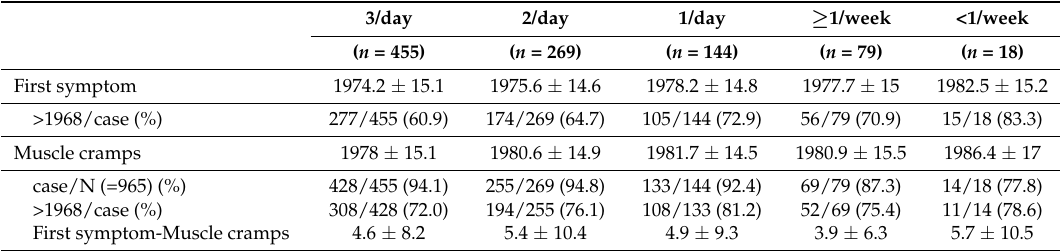
Table 13. Average onset year of symptoms and interval from the first symptom in each category of fish ingestion ( n = 965).